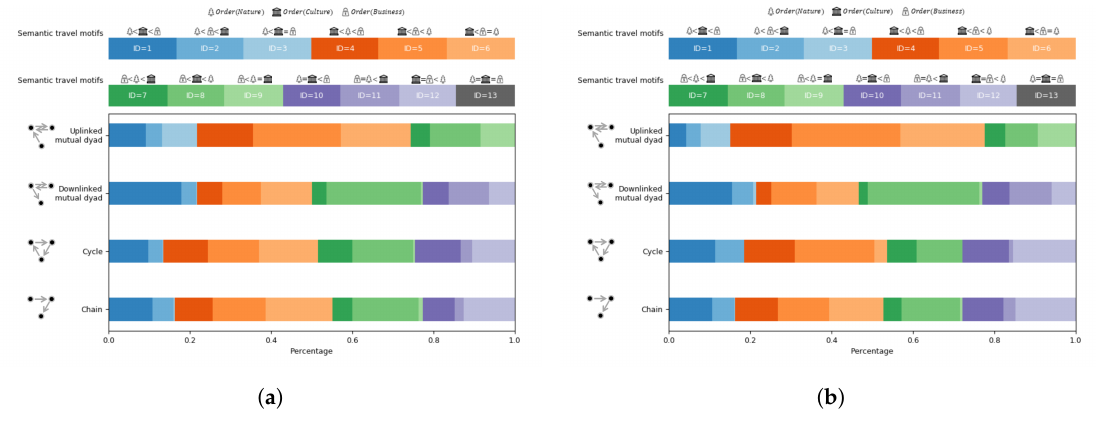
Figure 5. Statistical characteristics of semantic travel motifs based on ( a ) discrete sequence and ( b ) consecutive